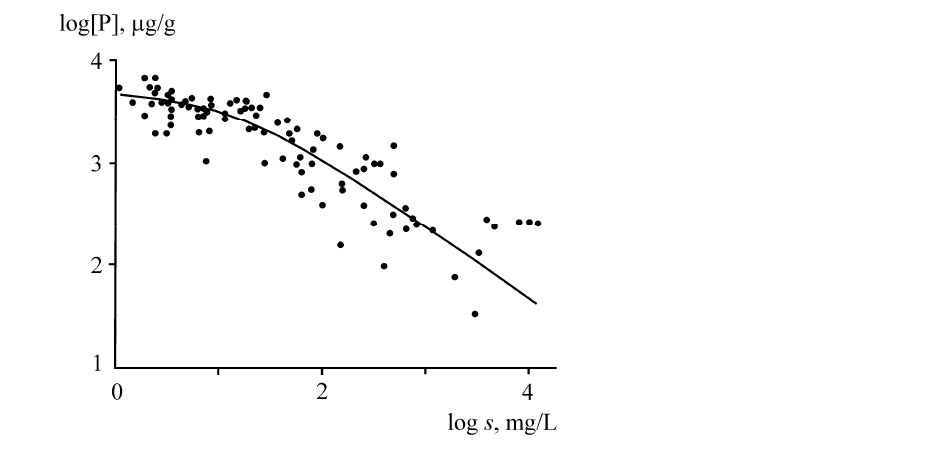
Table 10. The average content of dissolved phosphorus ( µ g/L) in the river waters of different geographic zones